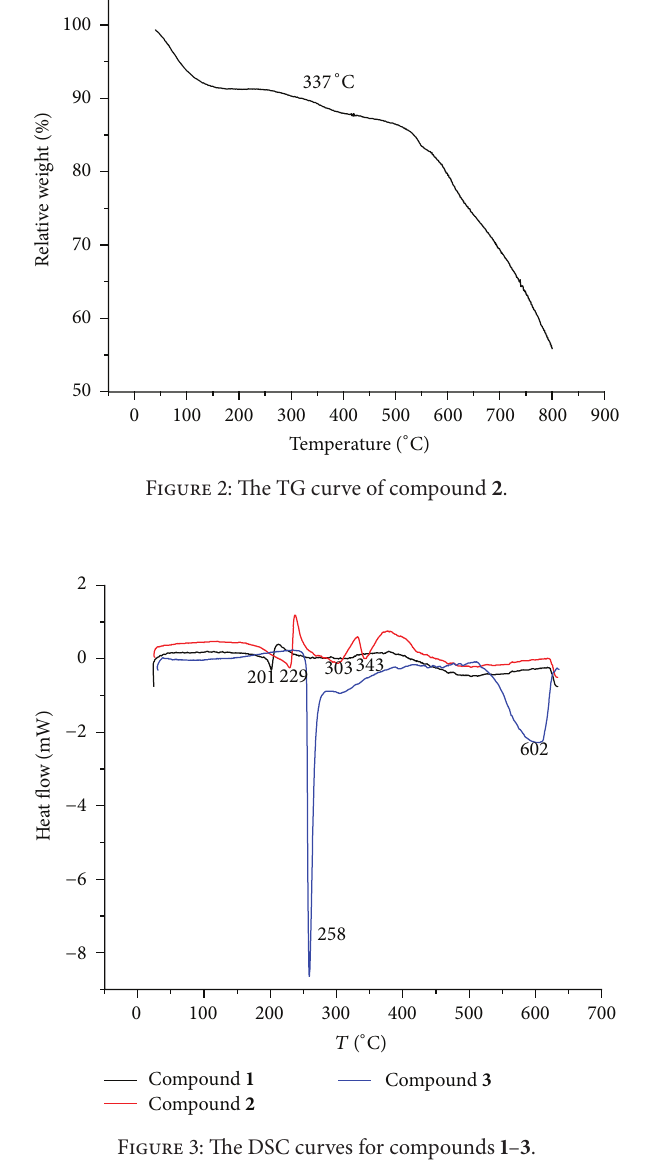
peaks for compounds 1 and 3 were 201 ∘ C and 258 ∘ C, respec- tively. There was another endothermic peak at 602 ∘ C for compound 3 which was a decomposition peak.